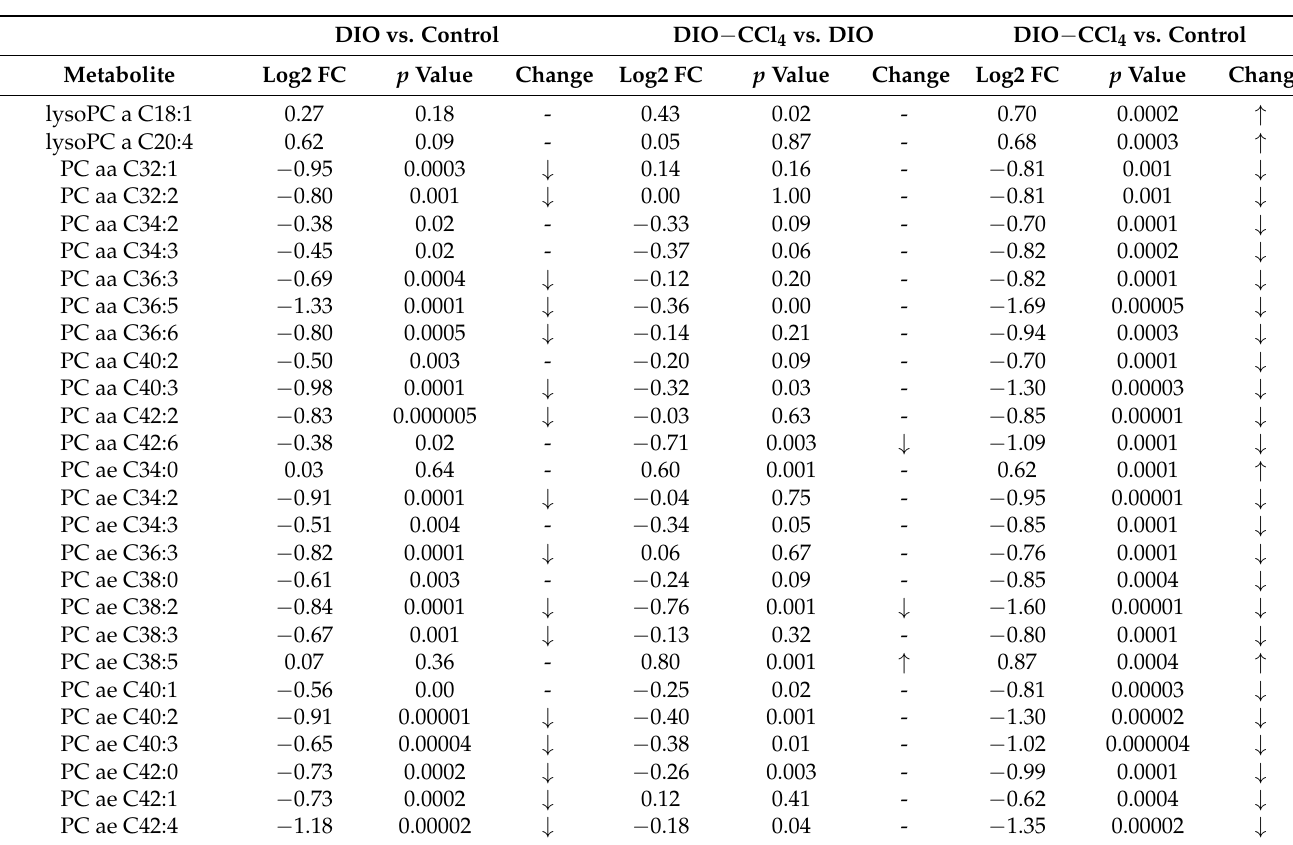
Table 2. Summary of differential metabolites in liver between different groups (PCs and LPCs). DIO vs. Control DIO − CCl 4 vs. DIO DIO − CCl 4 vs. Control